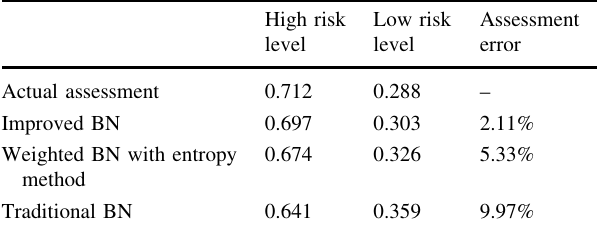
Table 13 Reasoning results of sea ice risk by different Bayesian network